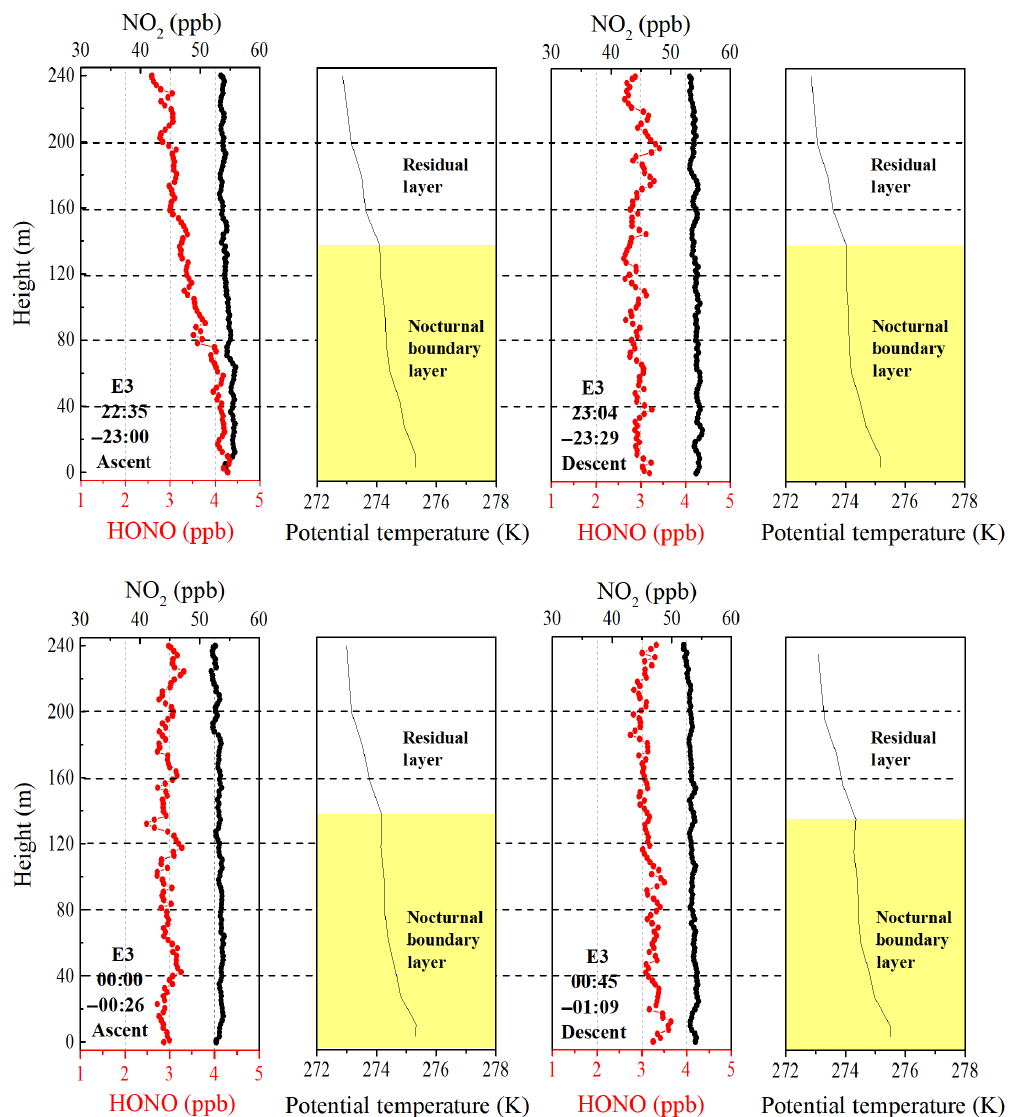
Figure 5. Vertical profiles of HONO and NO 2 on the night of 11 December and midnight of 12 December. The potential temperature profiles indicate nocturnal small-scale stratification (a nocturnal boundary layer and a residual layer). The height of the nocturnal boundary layer (NBL) is denoted by the yellow shaded region. The time in the figure corresponds to the measurement time of the vertical profiles of HONO and NO 2